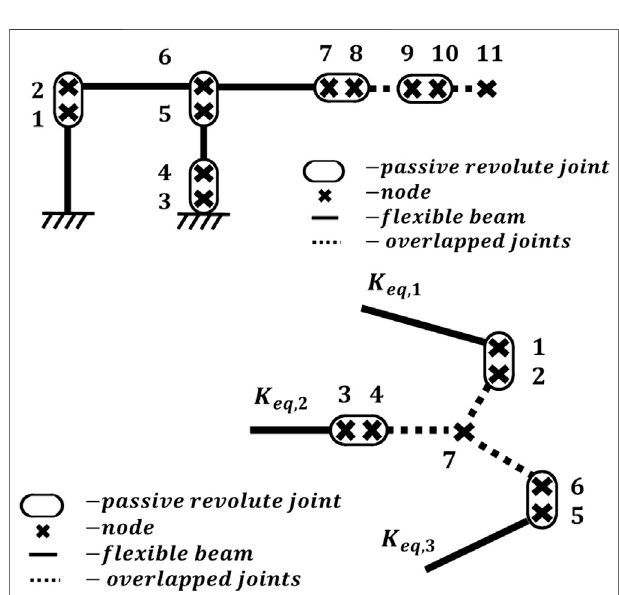
FIGURE 4 | (Top) 4-bar substructure equivalent nodal diagram (Bottom) shoulder plate end effector equivalent nodal diagram.